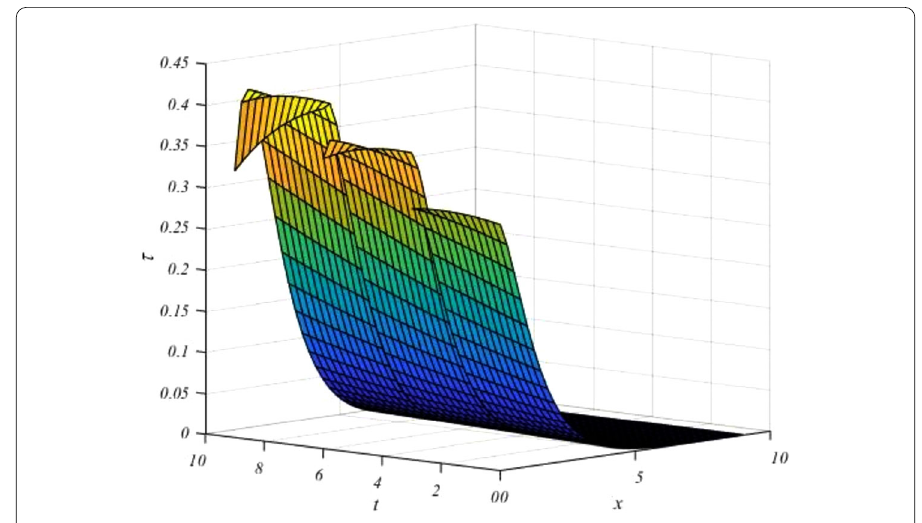
Figure 3 Three-dimensional view. 3D plot of tagged fish density with impulsive tagging. Here, t = k (cid:2) t , (cid:2) t = 3, k = 1,2,3,4, ... , c = 0.1, A = 1, B = 1, C = 0.3, D = 1.25, u = 0.05, τ 0 = 0.3, s 0 = 0.64, κ = 0.25, p = 0.2, ρ = 0.02 and t 0 =